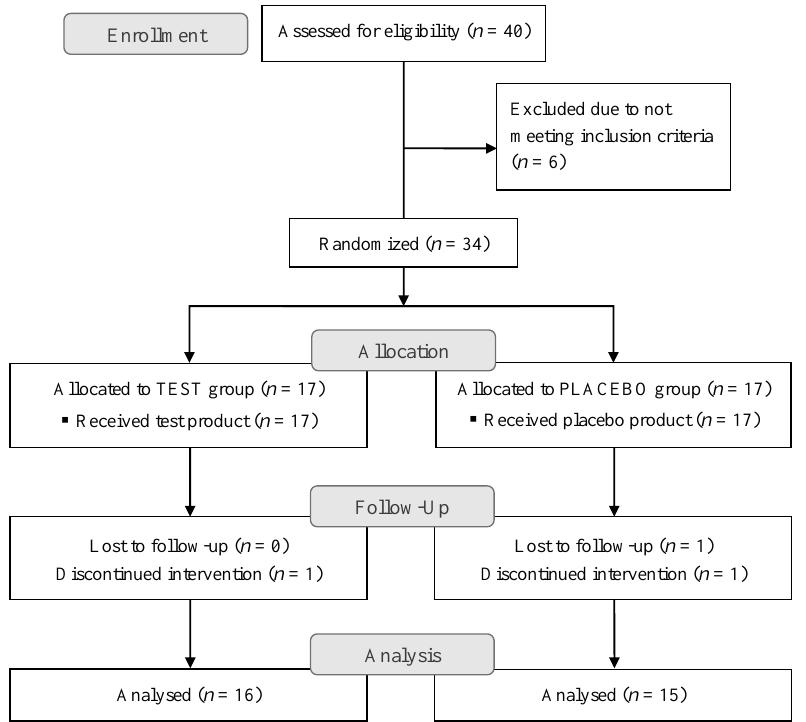
Figure 1. CONSORT (Consolidated Standards of Reporting Trials) flow diagram showing trial design and subjects’ assignment and progression through the trial.